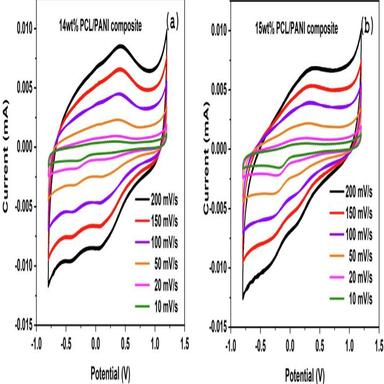
CV curves of (a) 14 wt%, (b) 15 wt% PCL and PANI composites.